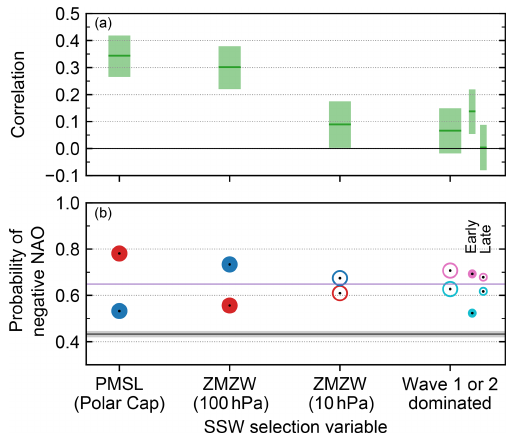
Figure 9. Summary of the impact of different factors on the 30d mean NAO response to SSWs. Four key results are highlighted: the best-performing 10d pre-SSW PMSL region, the 10d pre-SSW 60 ◦ N zonal-mean zonal wind at two different heights, and whether the SSW is wave-1 or wave-2 dominated at 50hPa (in terms of log 10 A 2 /A 1 ). We additionally show the impact of wave-1 or wave- 2 domination on the NAO in the first 10d post-SSW (labelled “Early”) and days 11–20 (“Late”). (a) Correlation between each factor and the post-SSW NAO anomaly, with 95% confidence in- tervals. Correlations for the PMSL and wavenumber factors have been inverted for ease of comparison. (b) Changes in the probabil- ity of a negative NAO, after selecting upper (red) or lower (blue) thirds of each precursor, or if the SSW is wave-2 (pink) or wave-1 (cyan) dominated. Filled circles indicate that the two probabilities are significantly different to each other. The overall rate of negative NAO responses to SSWs (as in Fig. 1d) is marked with a horizontal purple line. The black line with 95% confidence interval shading gives the climatological frequency of negative NAO conditions in random 30d periods that start in